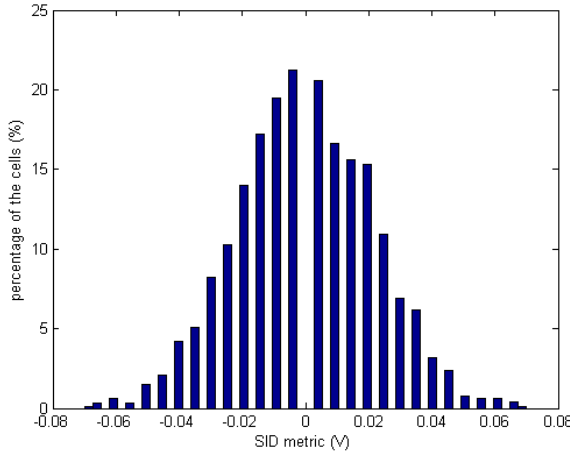
Figure 7. The histogram of the SID